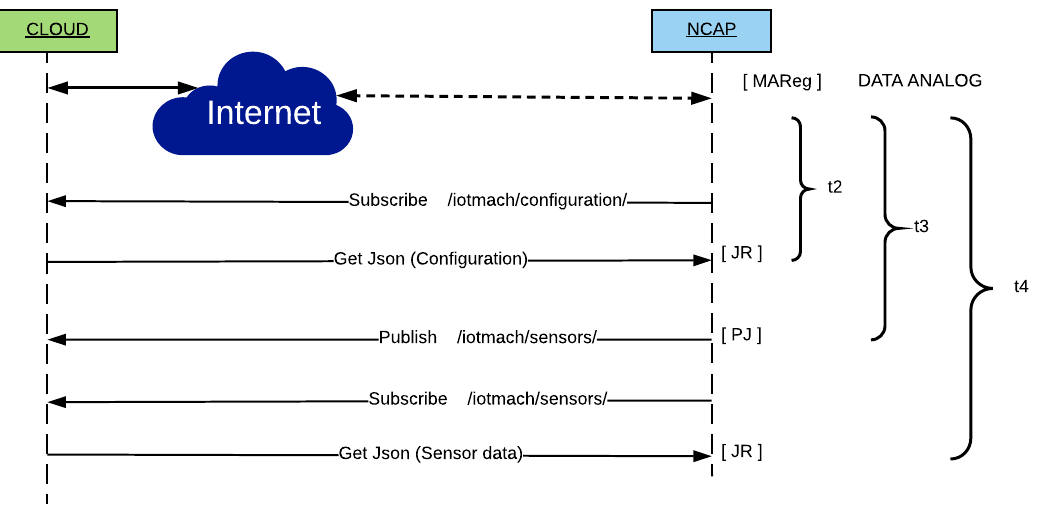
Figure 31. Sequence diagram that illustrates how to obtain the latencies for the BLE TIMs.